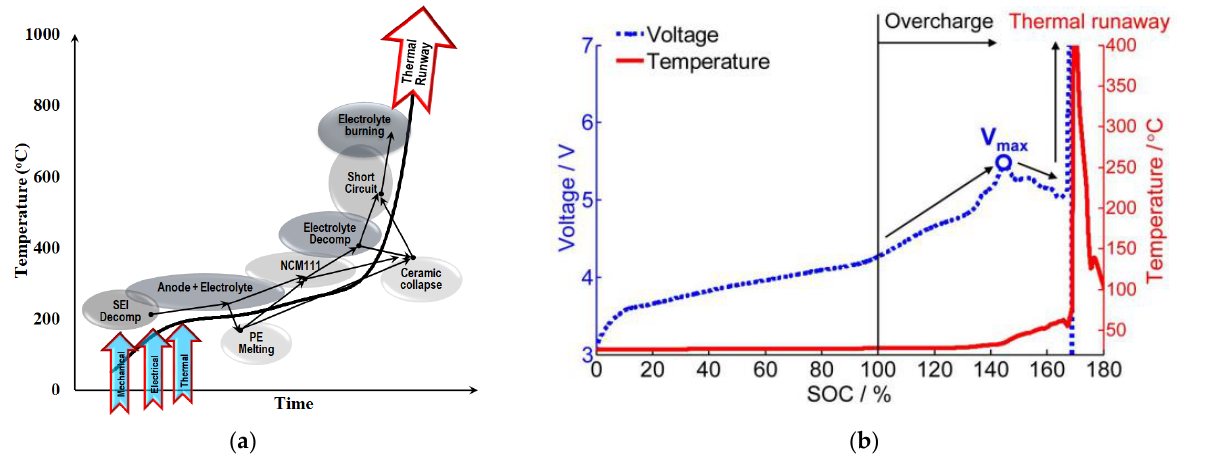
Figure 3. ( a ) Qualitative interpretation of the chain reactions during thermal runaway. ( b )